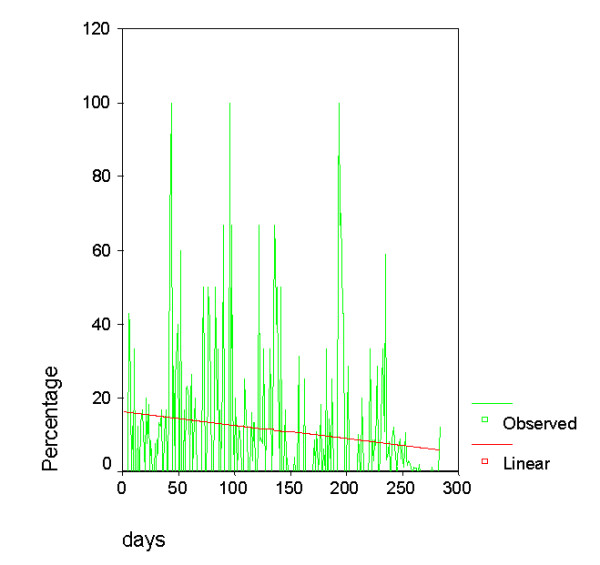
Distribution and regression of the percentage of unsatisfactory inspection results of premises inspected within the Olympic Venues 300 days before the end of the Olympics, r = 0.16, p < 0.001.